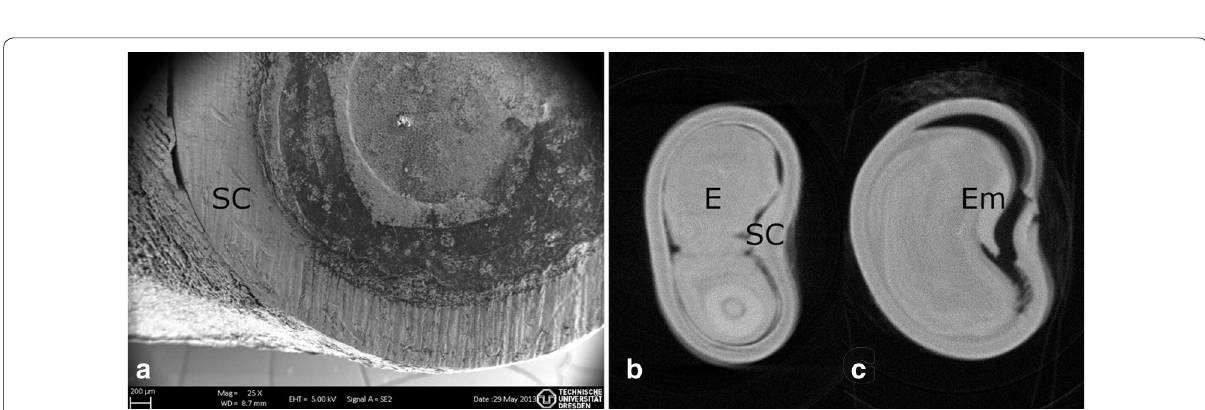
Fig. 2 Seed of Adansonia digitata . a SEM‑picture of the firm testa with a thickness of 700 µm, E endosperm, Em embryo, SC seed coat; ( b ) and ( c ) tomography in lateral view: ( b ) dry untreated seed; ( c ) seed after immersion in water at 100 °C. Due to the swelling cavities disappear and seed coat cracks open on the inside of the reniform